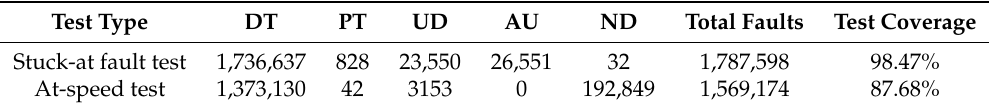
Table 3. Test results of the proposed